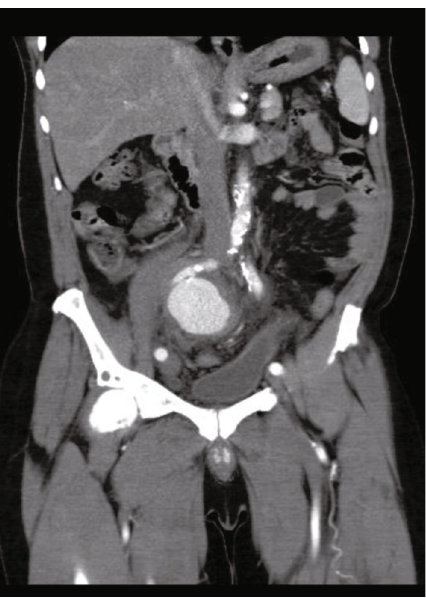
Figure 3: Contrast-enhanced CT scan of the abdomen and pelvis, with coronal images showing a large contrast- fi lled structure in keeping with iliac artery aneurysm compressing and pushing the urinary bladder